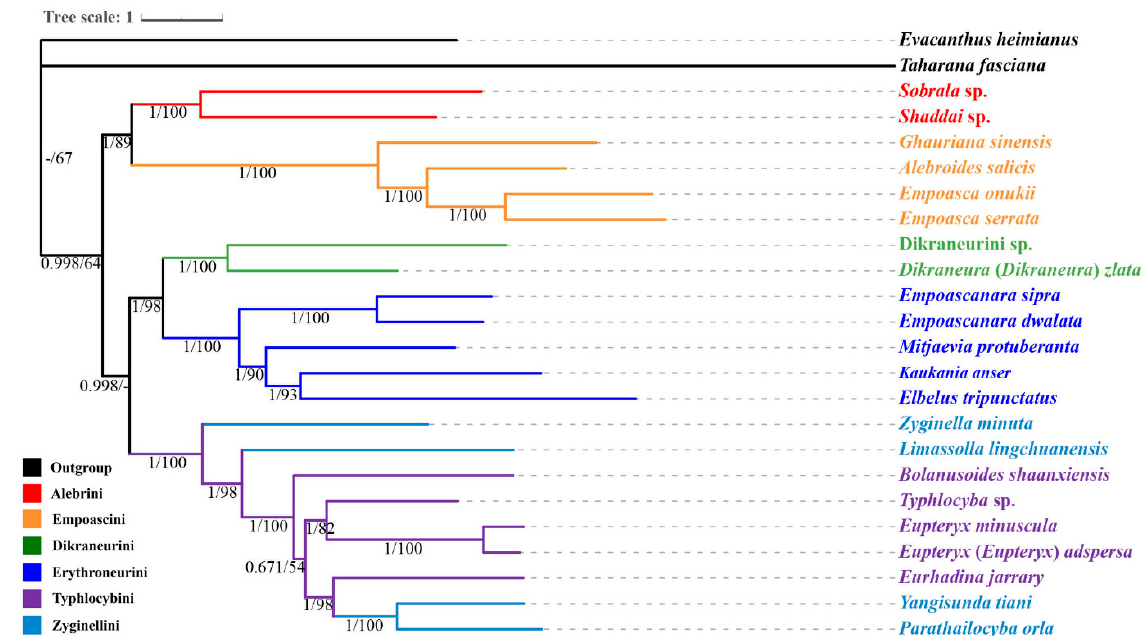
Figure 6. The phylogenetic tree produced using BI methods based on the dataset of PCG123. ML and BI analyses showed the same topology. The numbers under the branches are Bayesian posterior probabilities (PP) and bootstrap support values (BS).